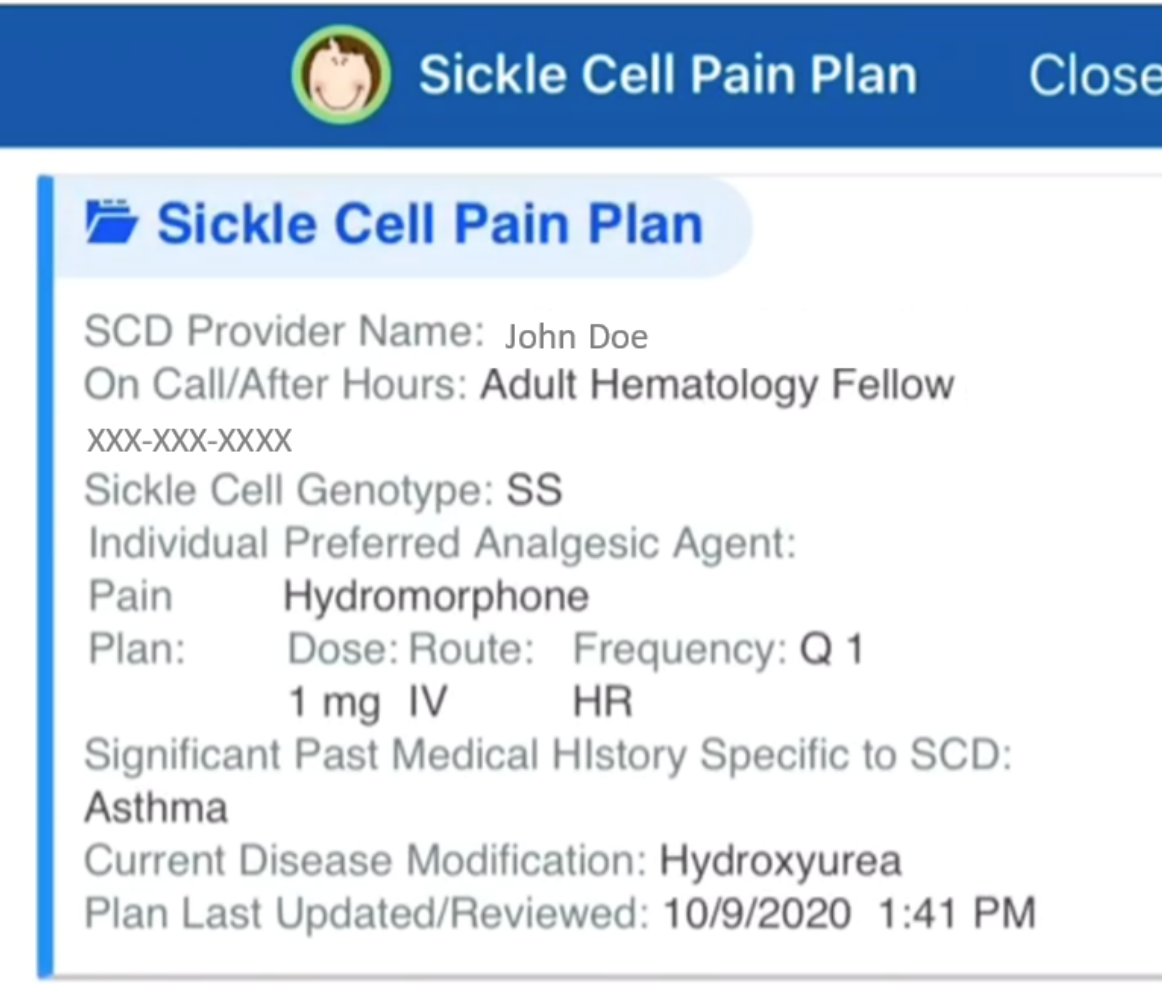
Figure 2. An example of an E-IPP patient portal (Washington University). E-IPP: electronic health record–embedded individualized pain